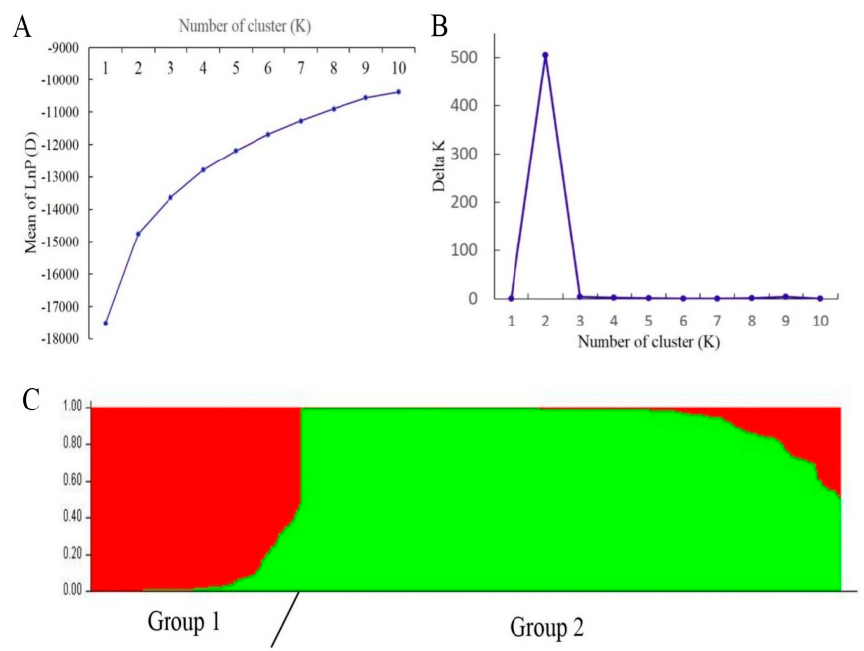
Figure 2. Population structure determined from 480 Pinus koraiensis individuals based on microsatellite data. ( A ) Estimation of population structure using mean lnP (D) with ten repetitions for K ranging from 1 to 10. ( B ) Estimation of population structure using delta K ( Δ K) with the number of clusters (K) ranging from 1 to 10. ( C ) Estimation of population structure of 16 populations based on structure analysis.